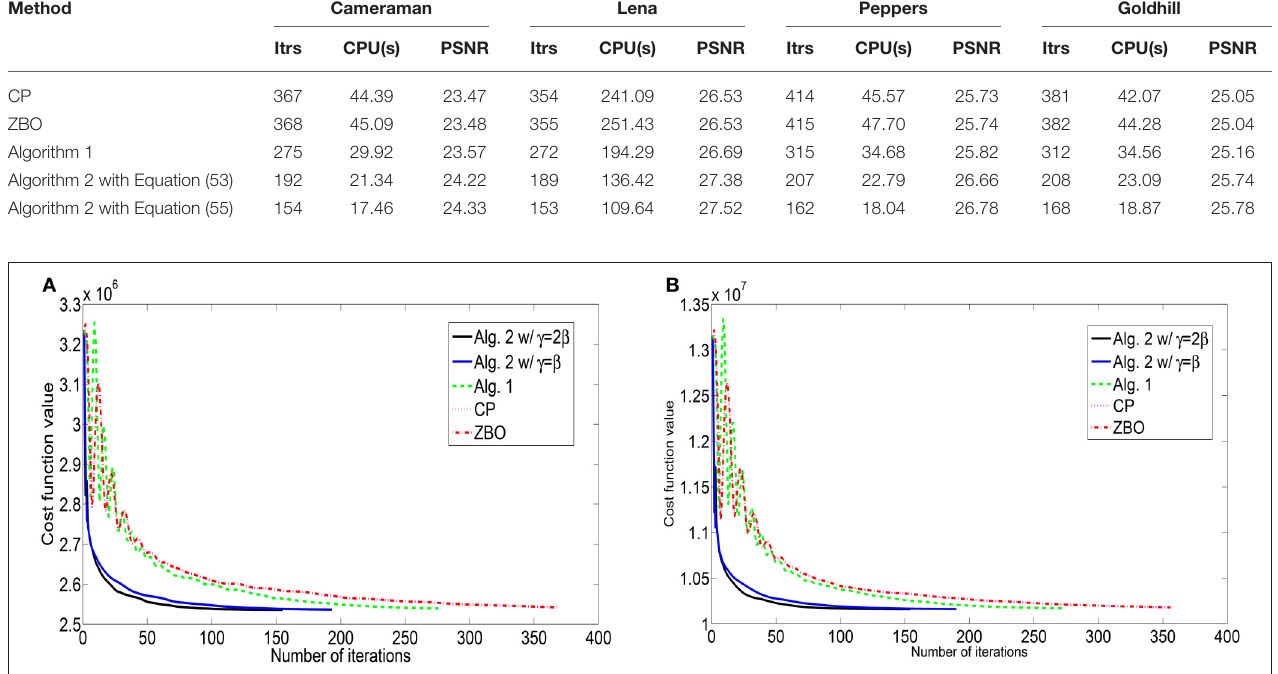
FIGURE 3 | Evolutions of function values of the L1-TV model for images of (A) “Cameraman” and (B) “Lena.”